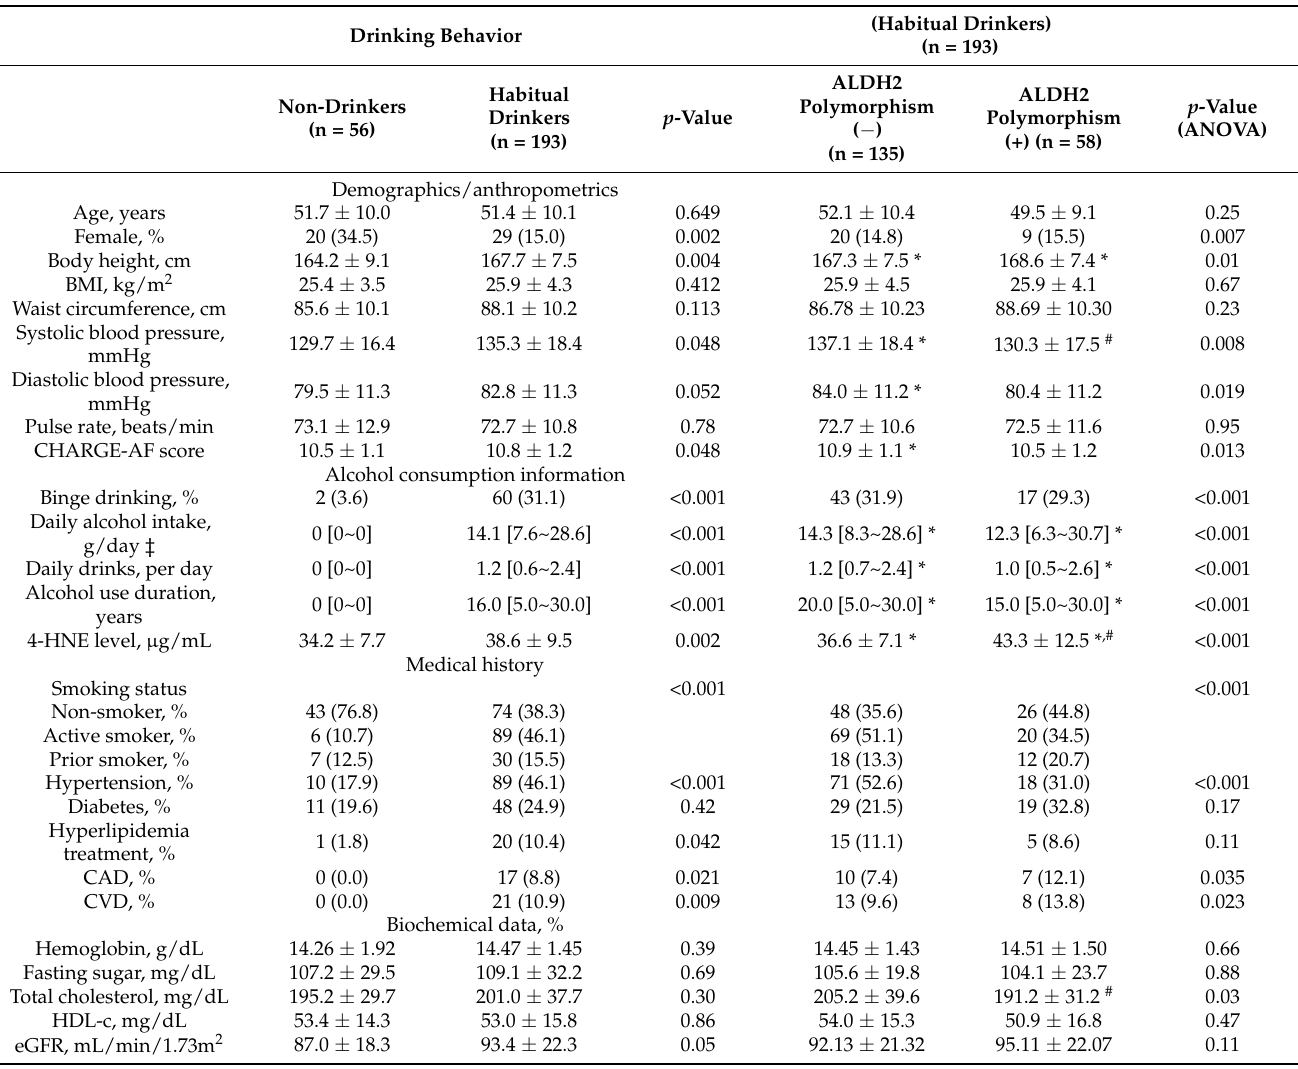
those without and with ALDH2 polymorphism, p = 0.25 for post hoc pairwise comparison between two groups), though this did not reach statistical significance. The 4-HNE level was significantly higher in habitual drinkers and was the highest in drinkers with ALDH2 polymorphism (34.2 ± 7.7 vs. 36.6 ± 7.1 and 43.3 ± 12.5 µ g/mL, respectively, p < 0.001). Habitual drinkers, regardless of the presence of ALDH2 polymorphism, were generally more likely to be active smokers or prior smokers, more likely to have a history of hyper- tension, hyperlipidemia treatment, and a higher prevalence of CAD and CVD compared to non-drinkers ( p < 0.05). Overall, the biochemical data were broadly comparable between the groups. Table 1. Baseline demographic information, alcohol consumption patterns, and 4-HNE adduct levels across non-drinkers and habitual drinkers without and with the presence of ALDH2 polymorphism.